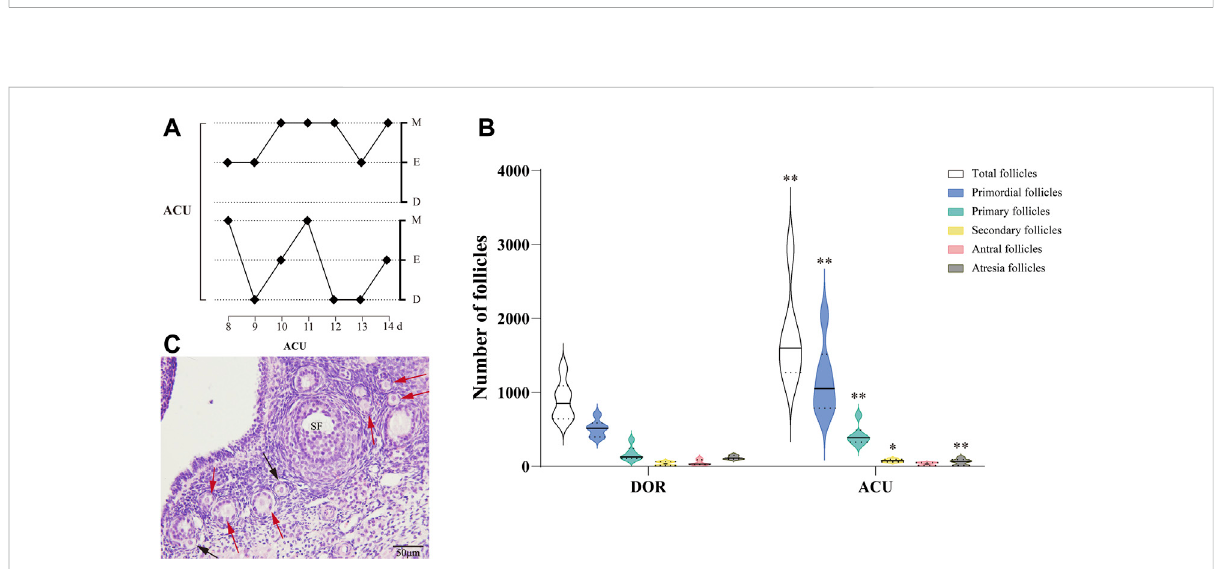
Acupuncture improves the ovarian reserve in DOR rats. (A) Estrous cycles in the ACU group. (B) Follicle counts in the DOR and ACU groups. (C)